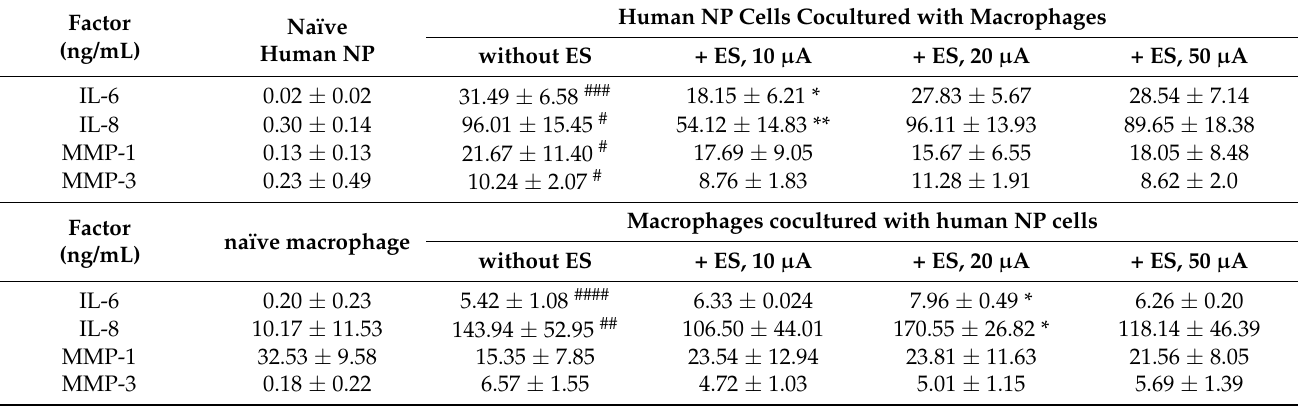
Table 1. Protein concentrations of inflammatory cytokines and ECM-modifying enzymes in NP cells and